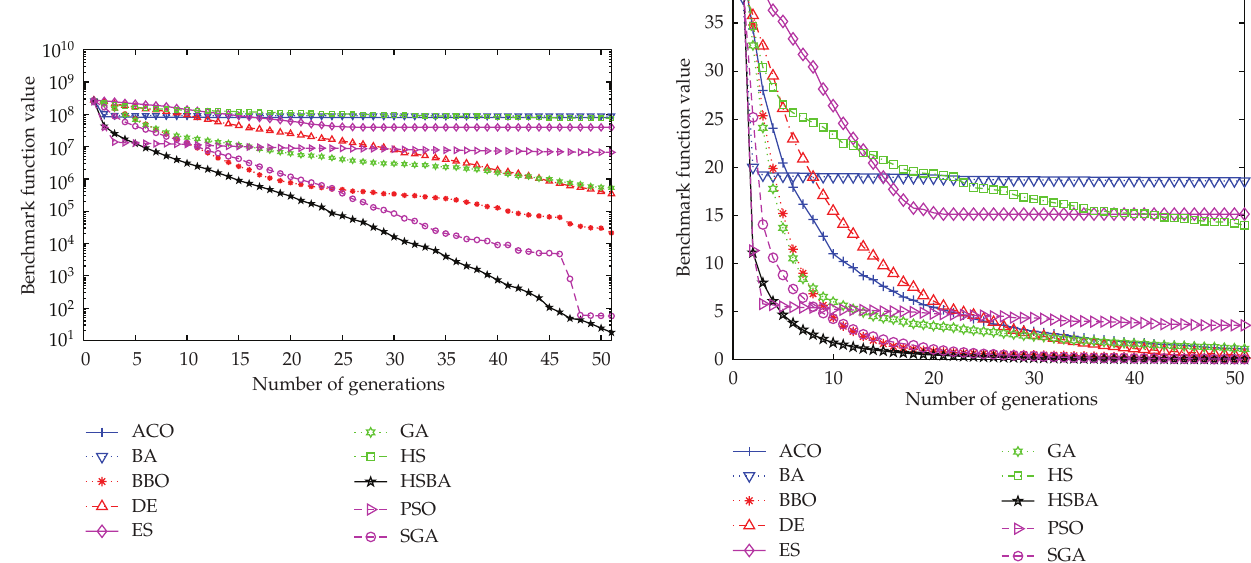
Figure 6: Comparison of the performance of the different methods for the F06 Quartic ( with noise )